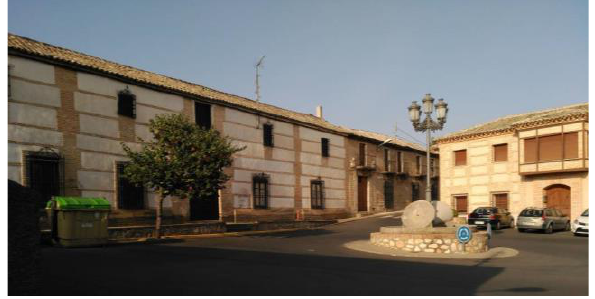
Figure 2. View of a square in Olias del